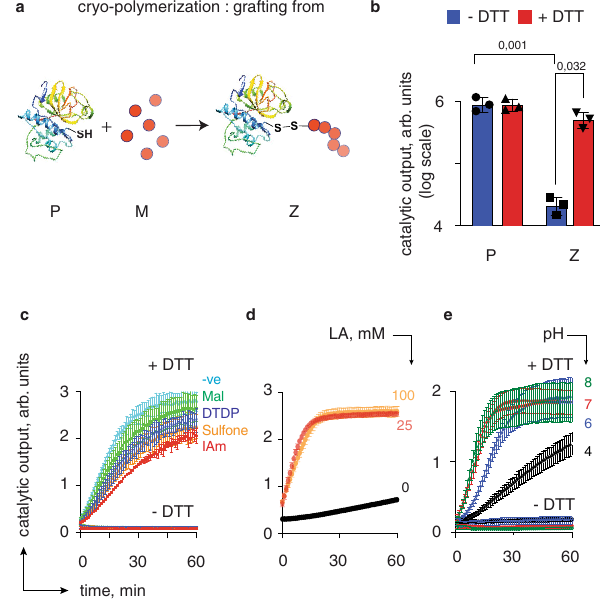
Fig. 2 | Design, synthesis, and characterization of the polydisul fi de-based zymogen of papain. a Schematic illustration of zymogen preparation via the “ grafting from ” polymerization route; P protein, M monomer; Z zymogen; b End- point measurements of enzymatic activity for P and Z, illustrating successful deactivation of papain by LA PDS and reactivation of catalysis via polymer decomposition; c Kinetic data for enzymatic catalysis in solutions of zymogens obtained from papain via polymerization of lipoic acid capped with thiol traps: IAm=iodoacetamide,DTDP=2,2 ’ dithiodipyridine,Mal=4-maleimidobutyricacid; Sulfone=phenyl vinyl sulfone; – ve=non-capped cryo-polymerization); d Enzymatickinetics data insolutions of papainexposed to iodoacetamide withor without polymerized LA; e pH dependence of kinetics of zymogen reactivation. Experimental conditions; [P, Z]=2 μ M; enzyme substrate: N- α -benzoyl-L-arginine- 7-amido-4-methylcoumarin hydrochloride, 5 μ M; 25mM borate buffer pH 8 (for buffer details in panel e : see experimental section); DTT 2mM. Panel c : shown representative results from individual runs; panels b , d , e shown are results from threeindependentexperimentsasmean±S.D.Statisticsinpanel b one-wayANOVA with the Sidak ’ s multiple comparisons test, * p <0.05; *** p